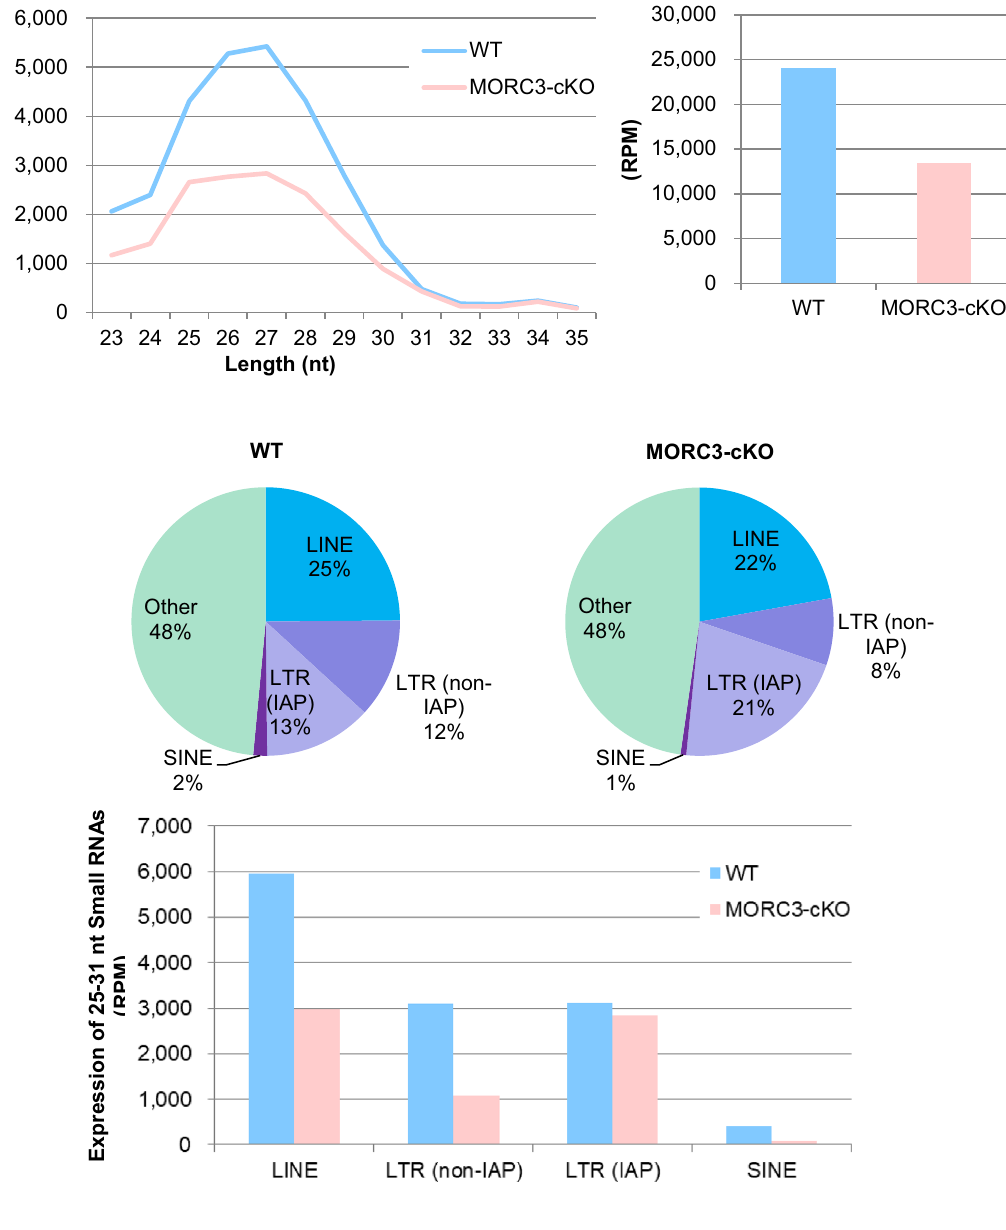
Figure 4. piRNA biogenesis and sequence profile in the MORC3 mutant embryonic testes. ( a ) Length distribution of small RNAs from E16.5 wild type and MORC3-cKO testes. Small RNAs were analyzed after ribosomal RNA (rRNA), micro RNA (miRNA), and transfer RNA (tRNA) mapped reads were removed by CLC Genomics Workbench. Light blue and pink bars show the wild type and MORC3-cKO data, respectively. The accession number of deep sequencing data is DRA011066. ( b ) Expression of 25–31 nt small RNAs corresponding to piRNAs in individual samples. ( c ) Genomic annotation and classification of repeat piRNAs based on retrotransposon class in the wild type and MORC3-cKO piRNA libraries (upper). Expression of piRNAs corresponding to LINE, LTR (non-IAP), LTR (IAP), and SINE in individual repeat piRNAs (bottom). ( d ) Expression of piRNAs derived from both strands (upper) and each strand (sense or antisense, bottom) corresponding to LINE1 A (M13002), LINE1 TF (D84391), and IAP (M17551) sequences in the wild type and MORC3-cKO piRNA libraries. ( e ) Length distribution of 25–31 nt small RNAs derived from each strand (sense or antisense, left). Nucleotide distribution of the 1st or 10th nucleotide of 25–31 nt small RNAs from each strand